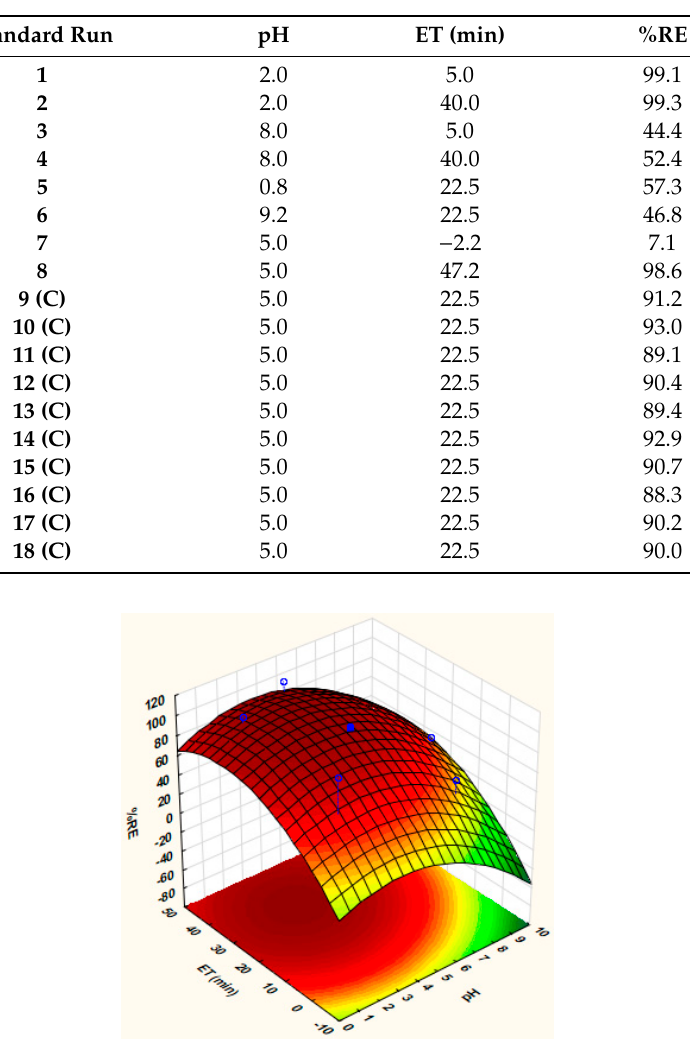
Table 2. Central composite design matrix and %removal e ffi ciency as an analytical response.